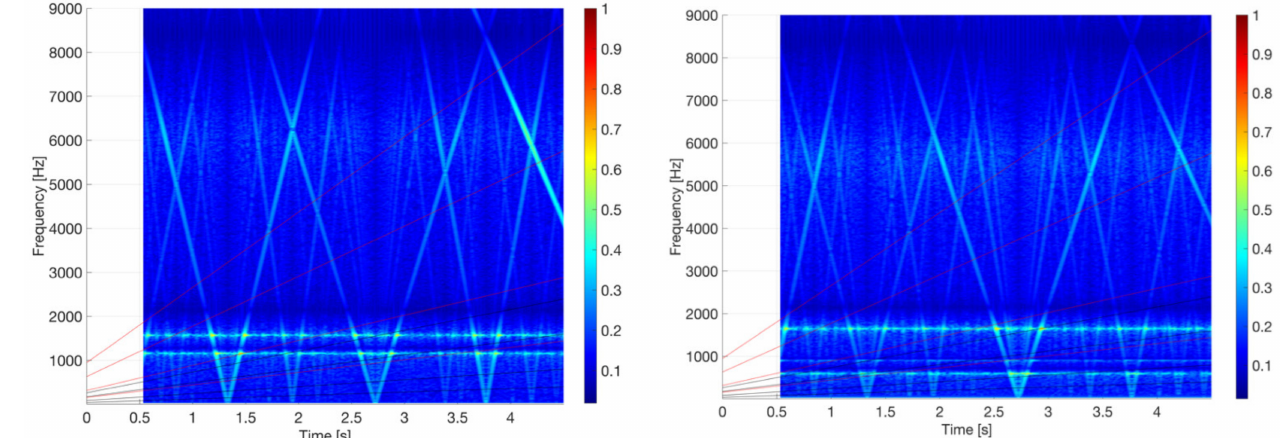
Figure 10. Spectrogram of torsional displacement on node 1 on the left for the solid web, on the right for the flexible web. The red and black sloped lines represent the harmonics of the meshing frequency of, respectively, pinion (red) and gear (black). The yellow circle indicates the crossing between a natural frequency and a harmonic of meshing frequency. Colormap reports the amplitude of the (cid:112) √ response and the unit is mm, this due to the little value of the